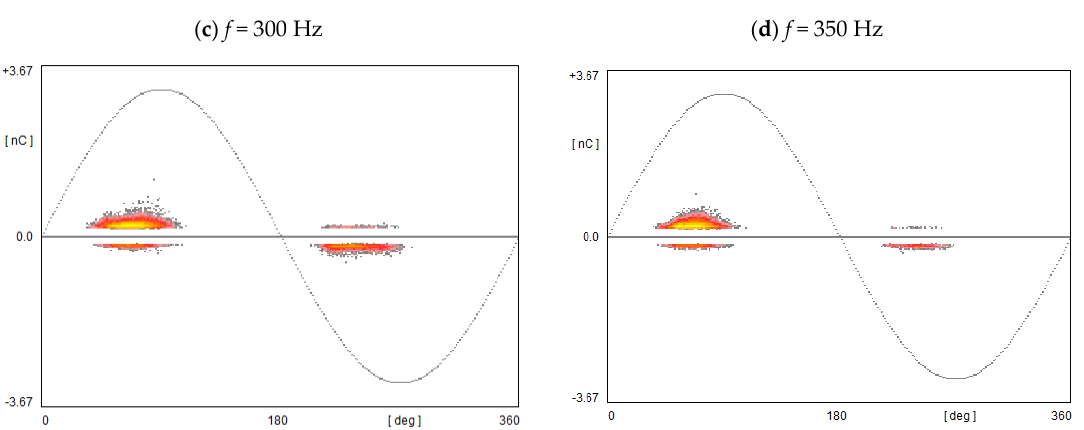
Figure 6. PRPD patterns at mixed DC 10 kV and AC 50 Hz U peak = 6 kV with frequency: ( a ) 50 Hz, ( b ) 150 Hz, ( c ) 300 Hz, ( d ) 350 Hz.